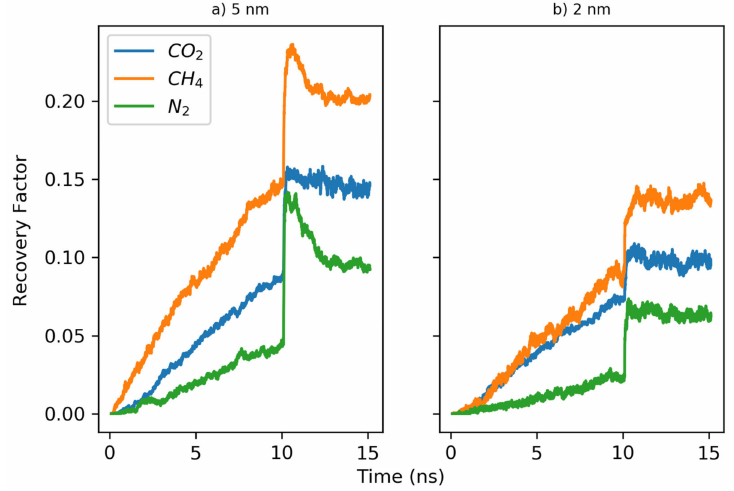
Figure 7. Recovery factors observed for Hu ff and Pu ff simulation: ( a ) pore width is 5 nm and ( b ) pore width is 2